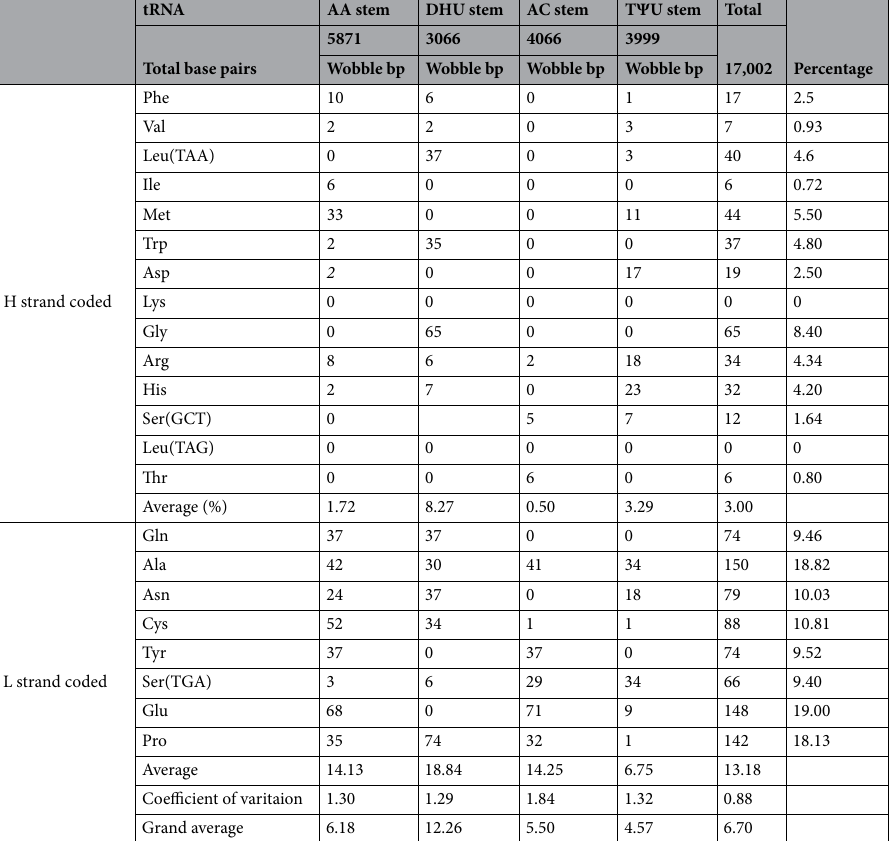
Table 3. Occurrence of wobble pairings in the stem regions of 22 tRNA genes in the mitogenome of 37 species of